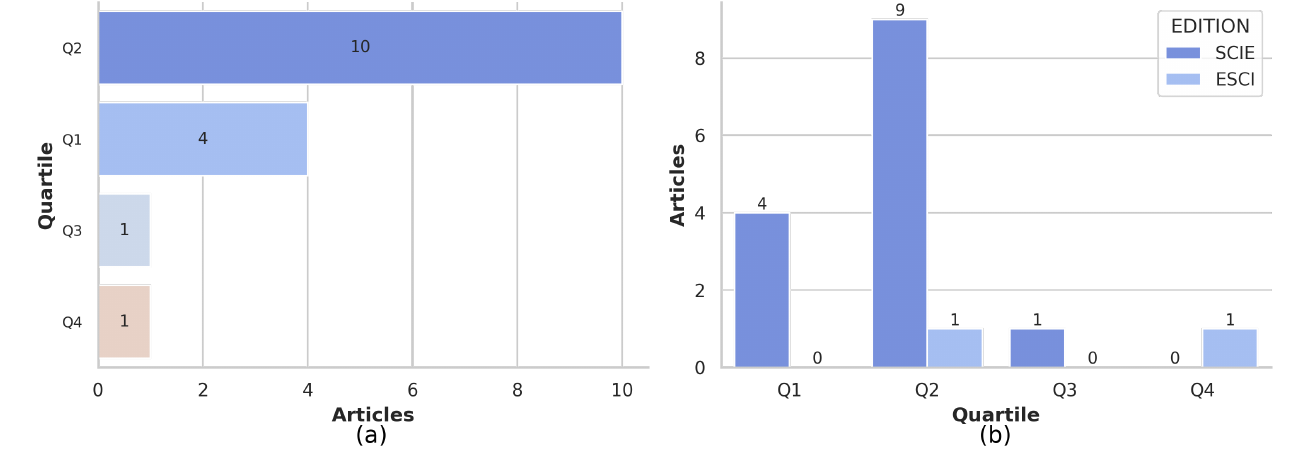
Figure 7. ( a ) Journal quartiles; ( b ) quartiles and types of